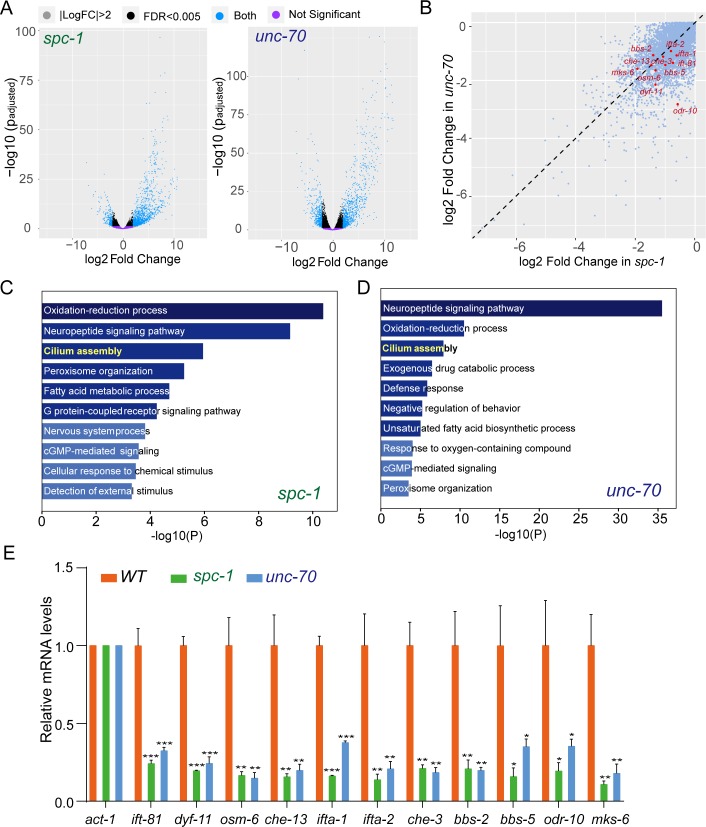
Spectrin promotes ciliary gene expression.(A) Volcano plot of DEGs between WT and spc-1 or unc-70 mutant animals. Biological replicates: N = 3 for WT, spc-1, and unc-70. (B) Scatter plot of the gene expression reduction in spc-1 and unc-70 mutant animals. Red genes correspond to the significantly down-regulated ciliary genes. (C–D) Gene enrichment analysis for the down-regulated genes in spc-1 or unc-70. Shown are the top 10 most significantly overpresented gene sets. (E) qPCR quantification of the ciliary genes and the control (an actin gene, act-1) transcripts in WT and mutants. Three biological replicates for all the genotypes. ***p < 0.001, **p < 0.01, *p < 0.05; one-way ANOVA (and nonparametric). Averages and SDs are plotted. Error bar, SEM. Data associated with this figure can be found in S1 Data. cGMP, cyclic guanosine monophosphate; DEG, differentially expressed gene; FDR, false discovery rate; LogFC, LogFold Change; qPCR, quantitative polymerase chain reaction; WT, wild type.